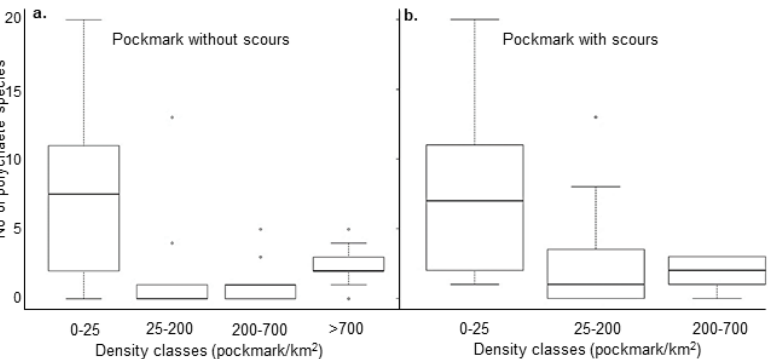
Figure 12. Boxplots of polychaete species richness among pockmark density classes ( a ) without scours and ( b ) with